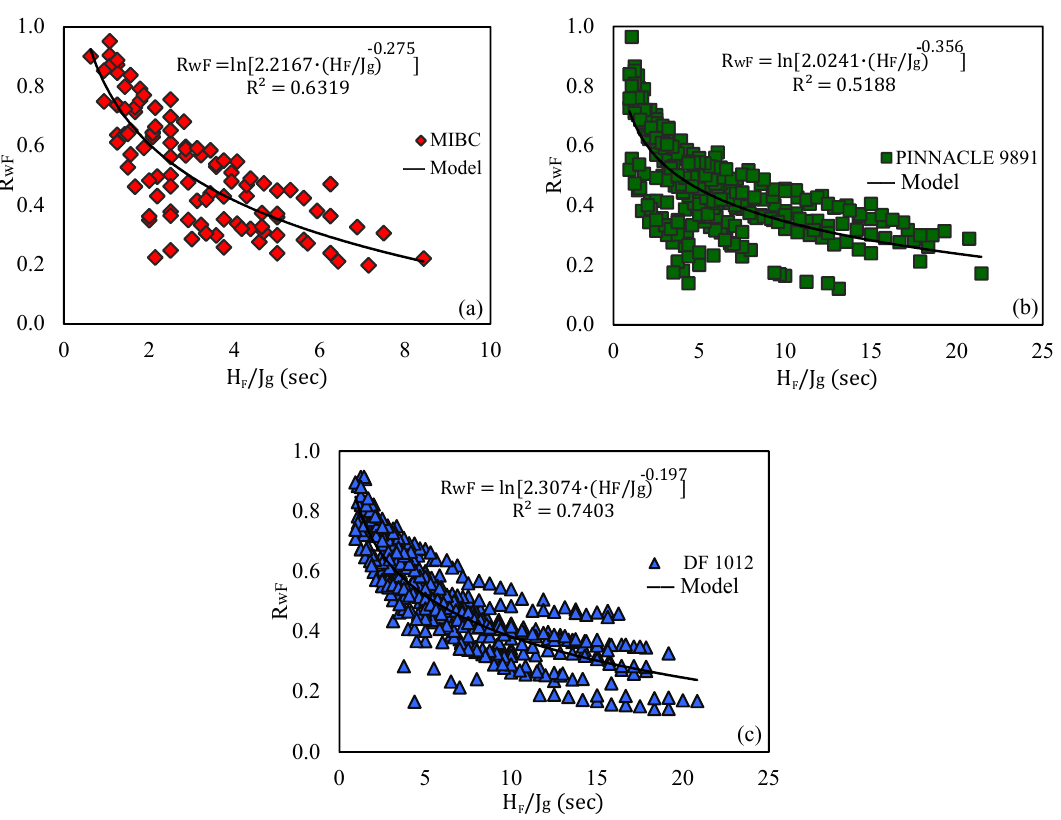
Figure 5. Froth water recovery as a function of the average air retention time in the froth (H F / J g ) for ( a ) MIBC, ( b ) PINNACLE 9891, ( c ) DF 1012.